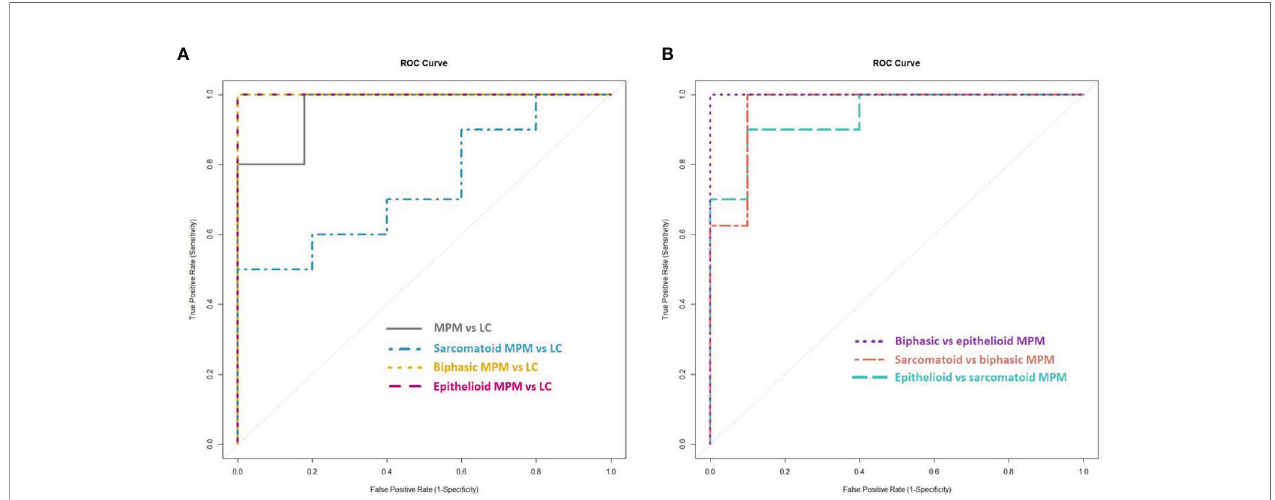
FIGURE 3 | Receiver operating characteristic (ROC) curves of the created lasso models. (A) ROC curves of the lasso models for the discrimination between the cell lines of (the histological subtypes of) malignant pleural mesothelioma (MPM) and lung cancer (LC). (B) ROC curves of the lasso models for the discrimination between the cell lines of the histological subtypes of